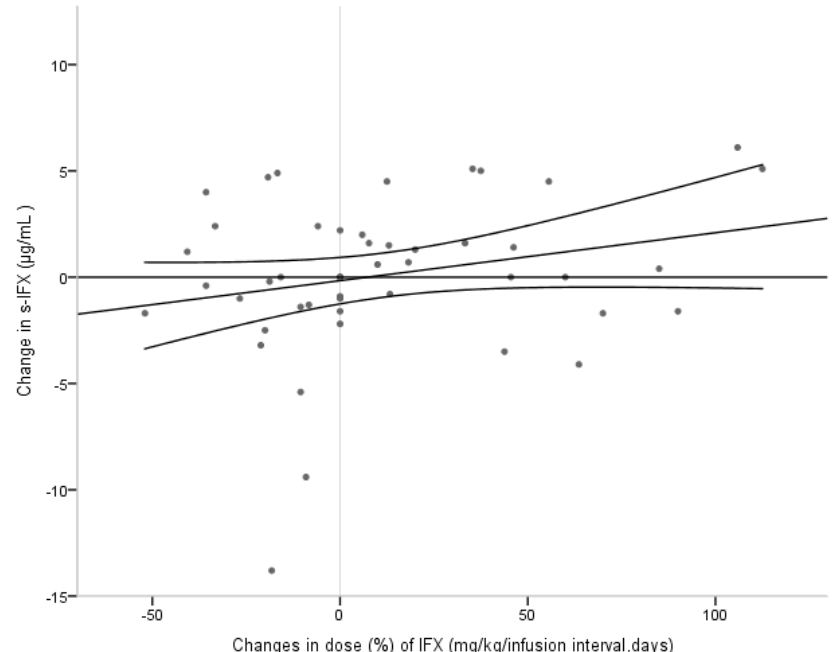
Figure 4. Change in dose (%) of IFX (mg/kg/dosing in days) did not show significant correlation with change in IFX trough levels in the 30 children who supplied two to four samples each ( p = 0.58). The changes in s-IFX were based on samples obtained between approximately one to thirteen months apart.